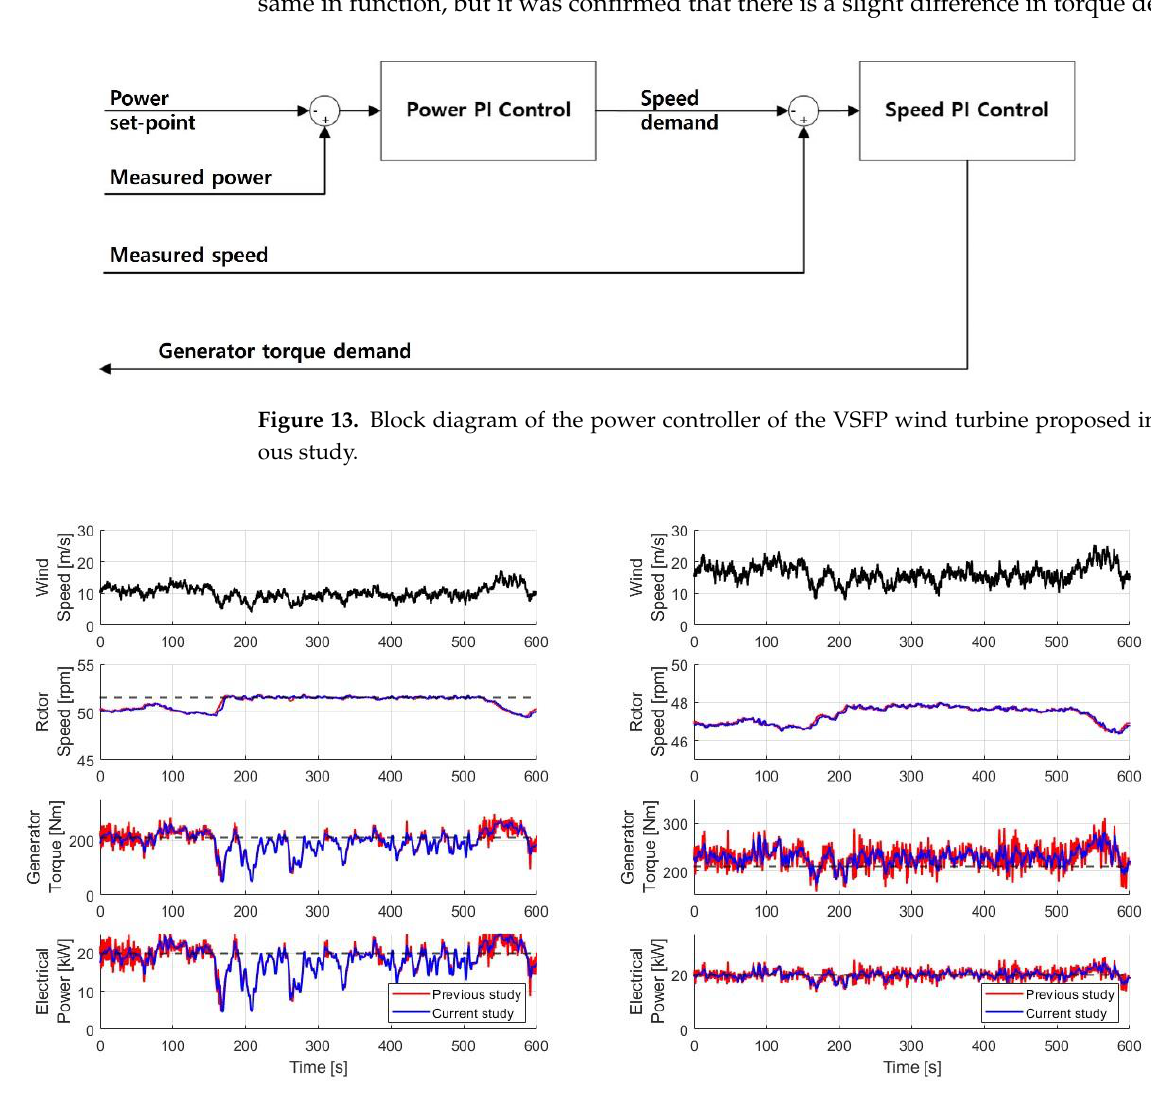
Figure 13. Block diagram of the power controller of the VSFP wind turbine proposed in a previous study.